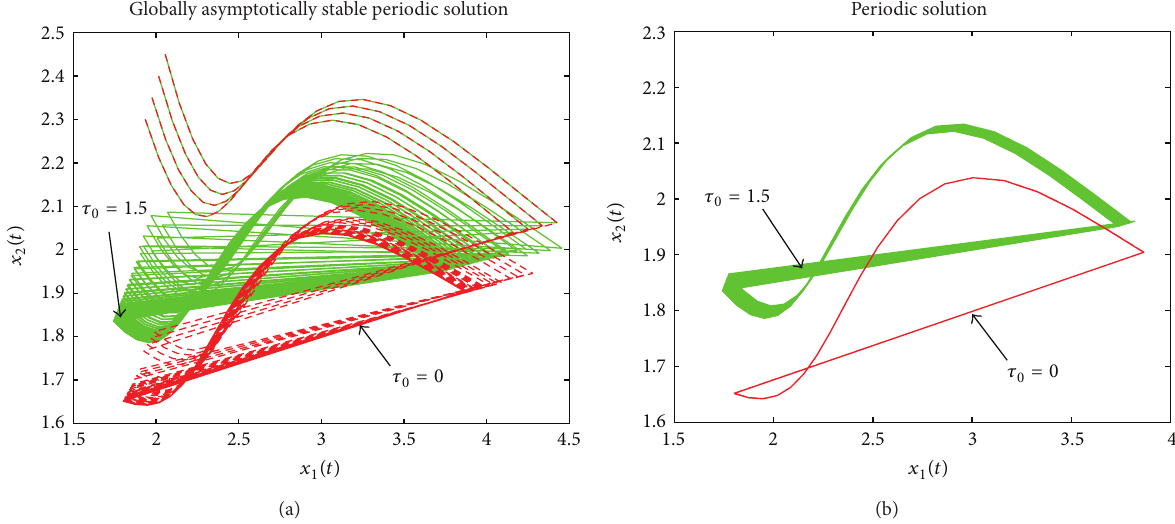
Figure 4: (a) and (b) Dynamical behavior of system (4). We take a series of initial points, such as (1.935,2.3), (1.939,2.34), and (1.943,2.38).